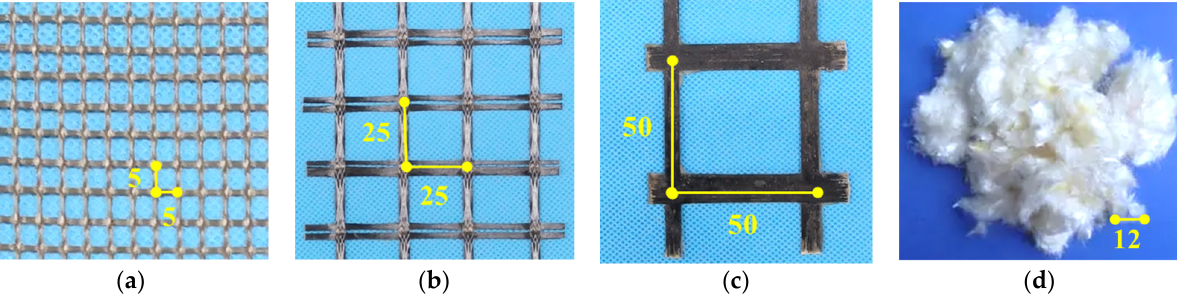
Figure 1. Basalt fiber grid and short PVA fiber (unit: mm): ( a ) T5; ( b ) T25; ( c ) G50; ( d ) short PVA fiber.